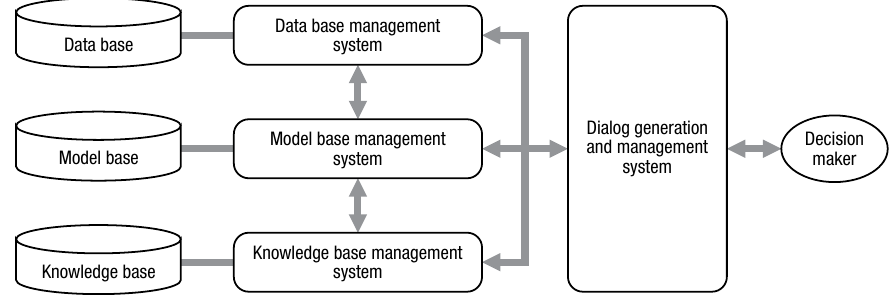
Fig. 1. The standard structure of the DSS